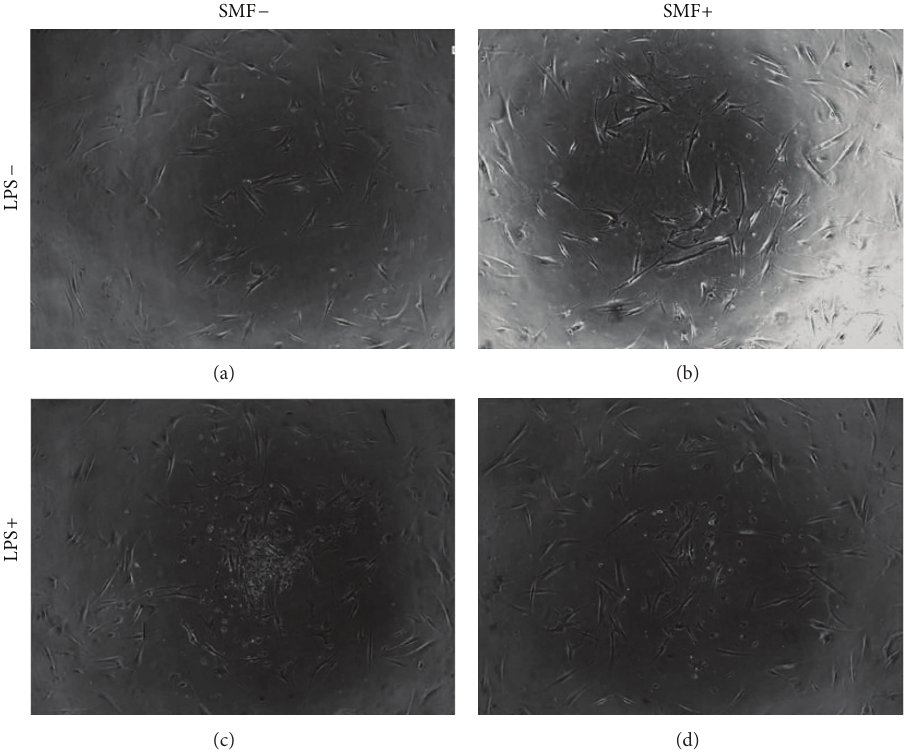
Figure 8: Representation of the optical microscope images of DPC cultures. (a) Sham-exposed DPCs showed fusiform to polygonal shape in a monolayer distribution. (b) There was no difference in cell shape or growth pattern in DPCs exposed to 0.4 T SMF. (c) When challenged with LPS, cell shape changed from fusiform to round, and much suspended debris appeared. (d) However, LPS-challenged DPCs cotreated with 0.4 TSMF had a lower level of shape disorder and suspended debris.